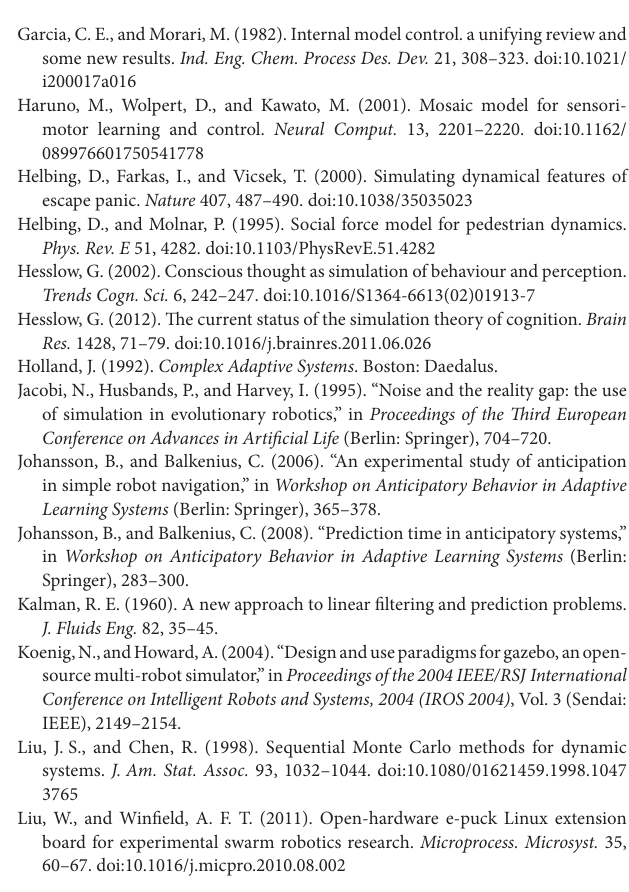
FigUre s1 | Exemplary run number 1 of the corridor scenario experiment showing only the performance of the CE controller. FigUre s2 | Exemplary run number 2 of the corridor scenario experiment showing only the performance of the CE controller. FigUre s3 | Exemplary run number 3 of the corridor scenario experiment showing only the performance of the CE controller. FigUre s4 | Exemplary run number 4 of the corridor scenario experiment showing only the performance of the CE controller. FigUre s5 | Exemplary run number 5 of the corridor scenario experiment showing only the performance of the CE